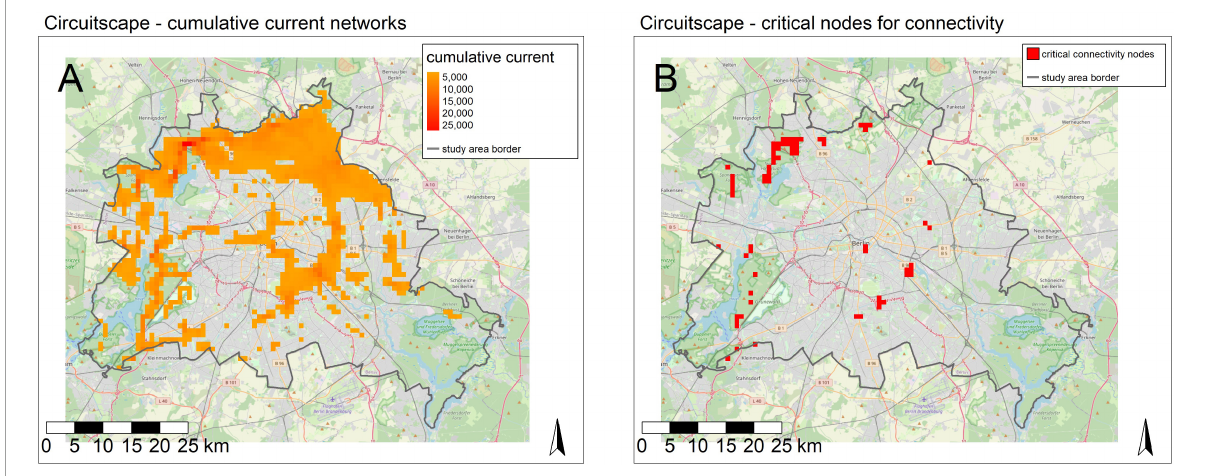
FIGURE6 Circuitscape model for connectivity of important habitat patches. (A) Cumulative current network and flow between important habitat patches. (B) Identification of critical nodes after threshold